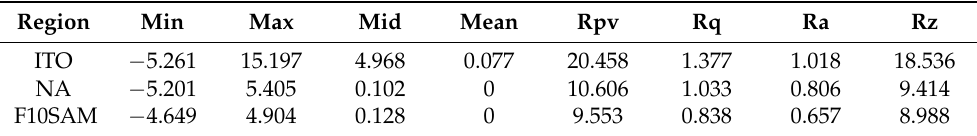
Table 1. Results of the roughness values (Mean—Mean line; Rpv—R peak to peak value, Rq—R root mean square, Ra—R average, and Rz—ten-point